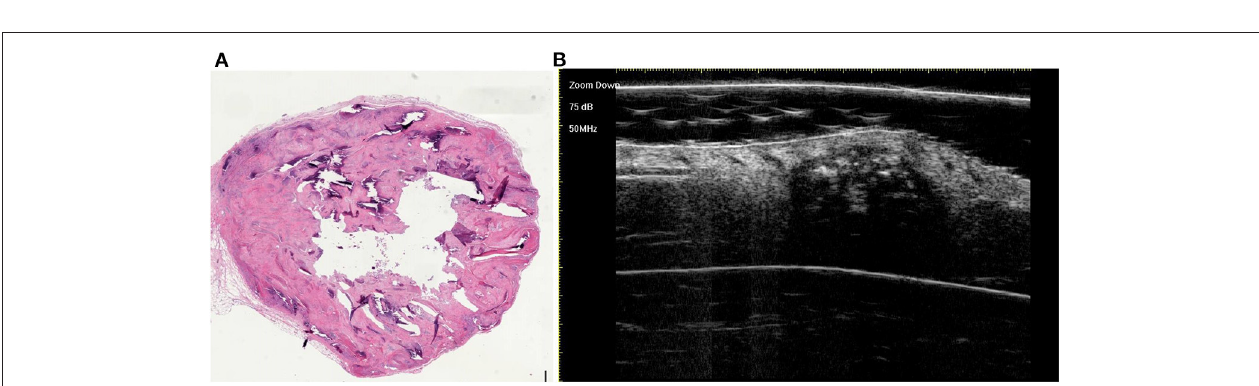
FIGURE 4 | The histological presentation [ (A) HE, original magnification × 25] and ultra-high frequency ultrasound (B) of PM in the fully developed stage, indicating scattered dot calcification.